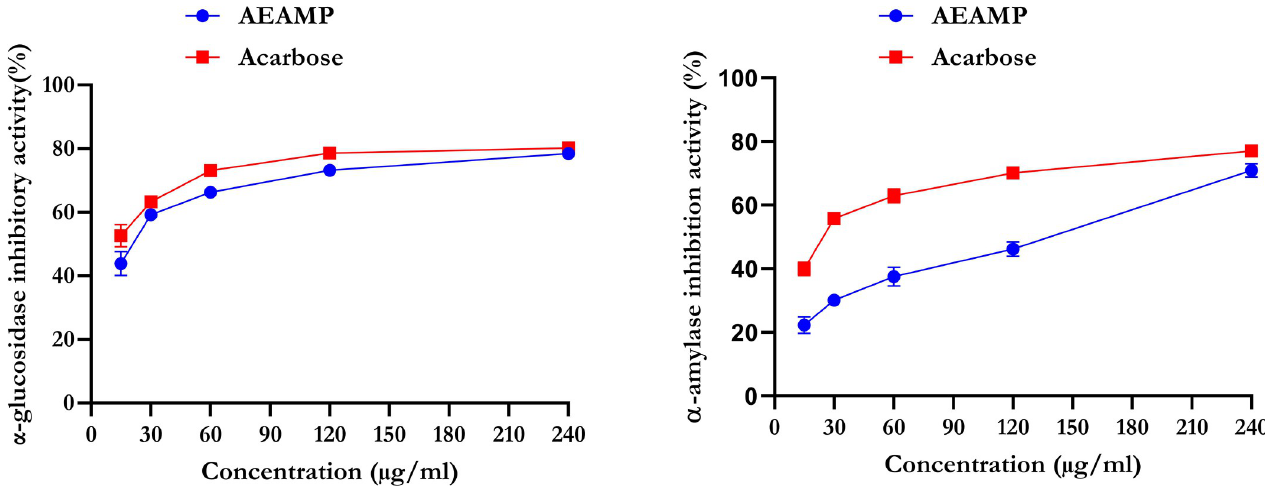
Fig 2. α -glucosidase and α -amylase inhibitory activities of aqueous extract of A . muricata peels. Data are expressed as mean ± SD of triplicate determinations. AEAMP: aqueous extract of Annona muricata peels.